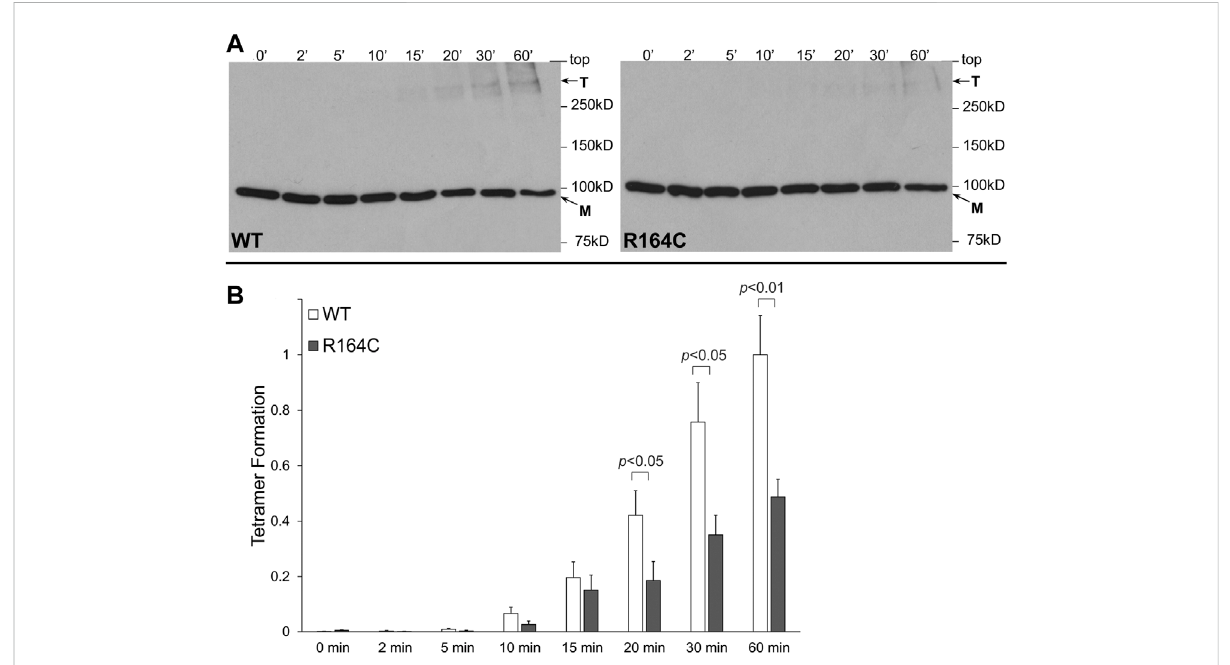
FIGURE 1 MH mutation R164C disrupts RyR1 NTD tetramerization. Chemical cross-linking assays of HEK293 cell homogenates expressing NT RyR1 − WT (rabbit RyR1 residues 1 – 915, cMyc-tagged) or the R164C mutant, NT RyR1-R164C . (A). Cell homogenates were incubated with glutaraldehyde for the indicated time points under reducing (10 mM DTT) conditions and analyzed by Western blotting using Ab cMyc ; monomer (M) and tetramer (T) are indicated with thearrows. (B). Densitometry analysiswas carried out on thebands corresponding to tetramer and monomer moieties and used to calculate tetramer formation. Data ( n = 7) are given as mean value ±SEM; statistical analysis was carried out using Mann-Whitney